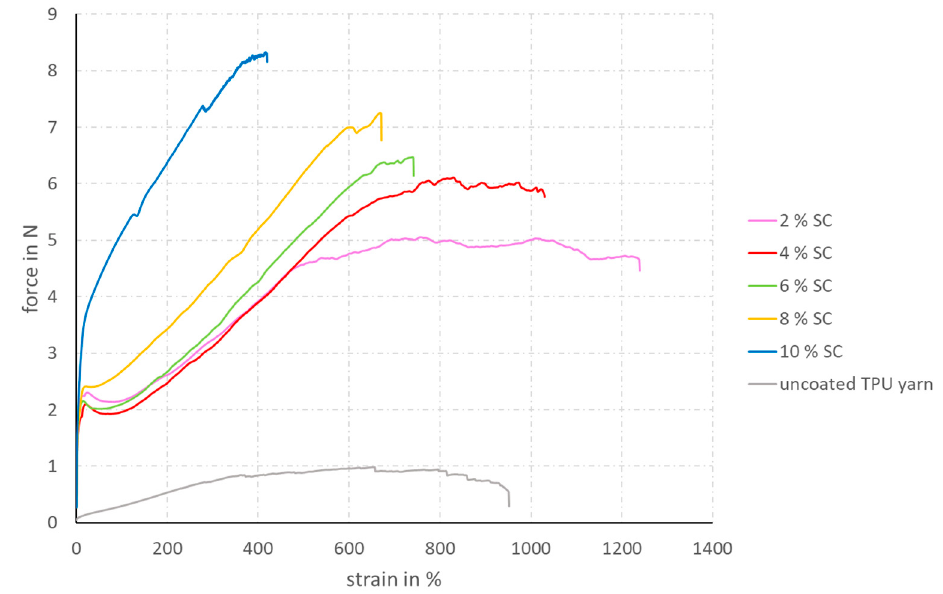
Figure 4. Strain–force diagram of TPU multifilament yarns coated with coating solutions containing different SCs and a constant content of 10 wt% CNT in the SC.